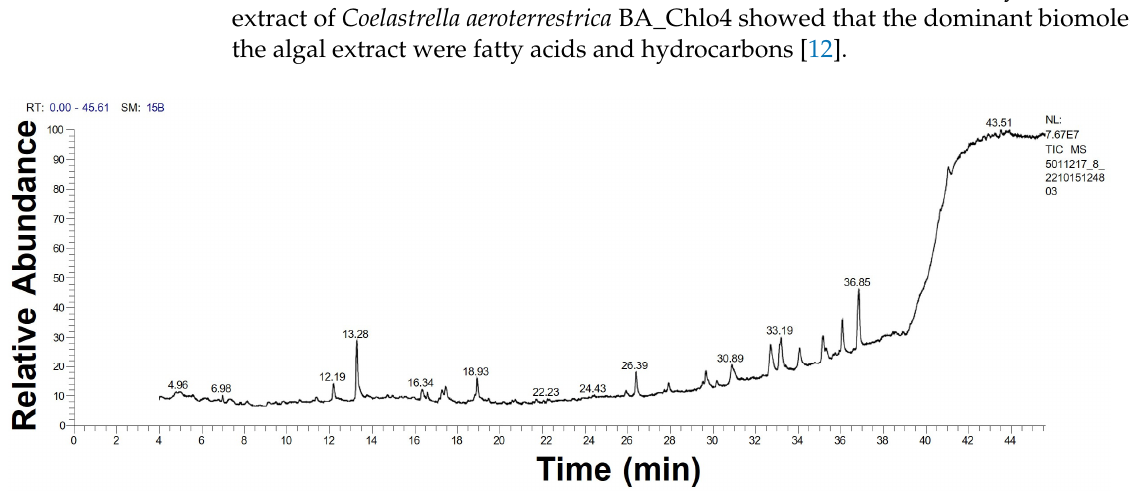
Figure 4. GC-MS chromatogram of unicellular ulvophyte sp. MBIC10591 watery Figure 4. GC ‐ MS chromatogram of unicellular ulvophyte sp. MBIC10591 watery extract. Table 1. Chemical composition analysis of the unicellular ulvophyte sp. MBIC10591 using GC ‐ MS.